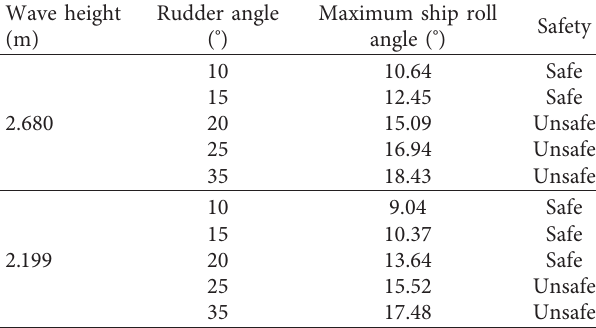
Table 7: Relationship between the steering angle and the maximum roll angle at the initial speed of 26km/h.